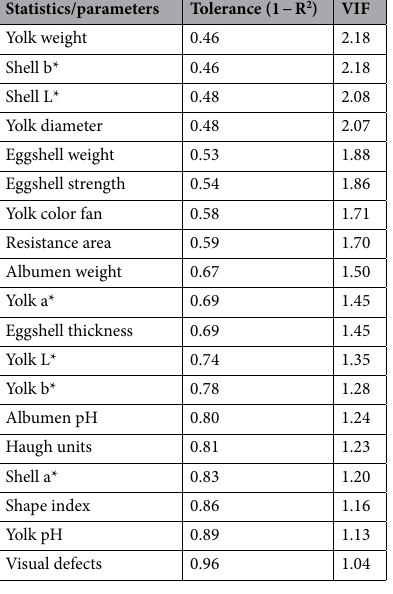
Table 1. Multicollinearity analysis of quality-related traits of eggs. Interpretation thumb rule: VIF = 1 (not correlated); 1 < VIF < 4 (moderately correlated); VIF ≥ 4 (highly